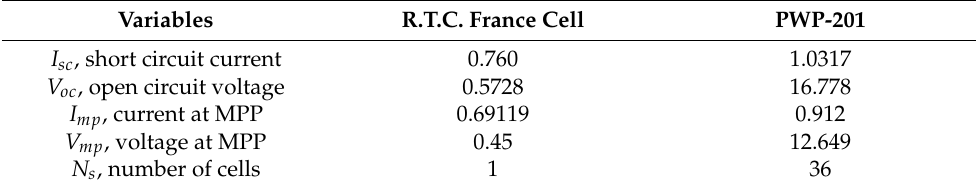
Table 1. Manufacturing parameters for the R.T.C. France cell and PWP-201 module [14].